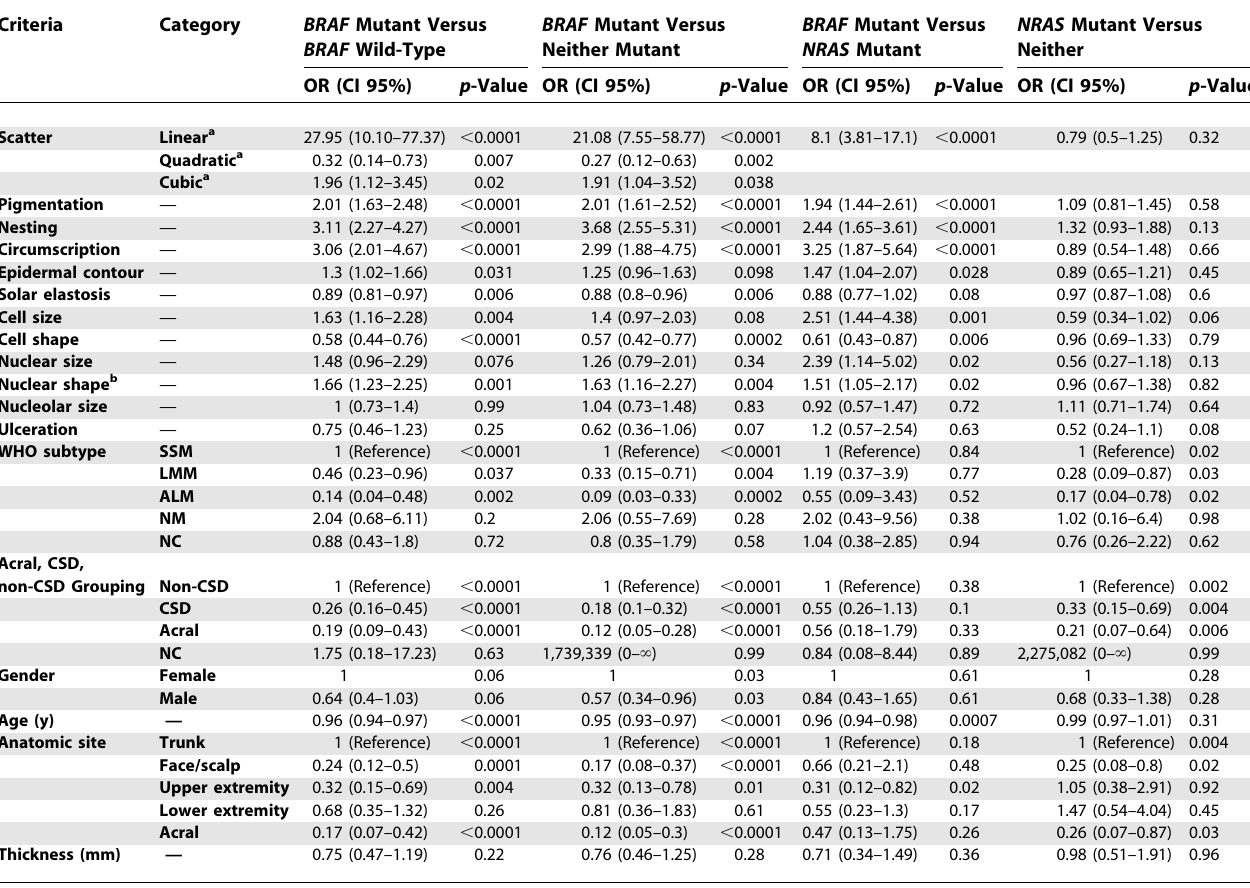
Table 3. Comparison of Morphological Variables Depending on the Mutation Status of BRAF and NRAS Criteria